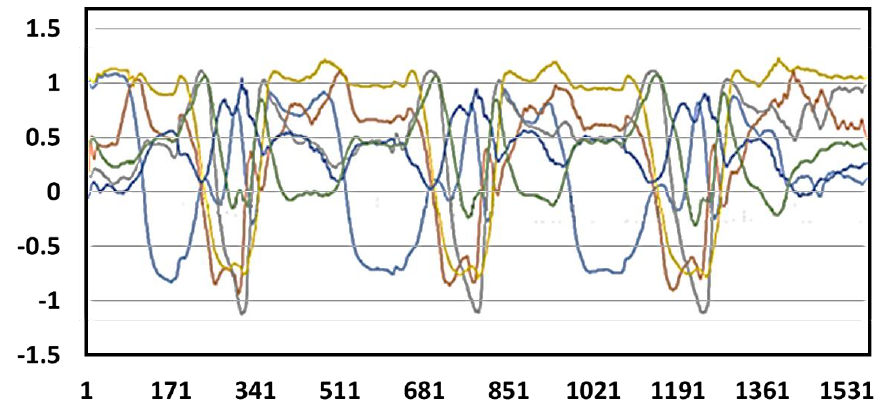
Figure 15. Continuous action signal in multiple throws using right hand .